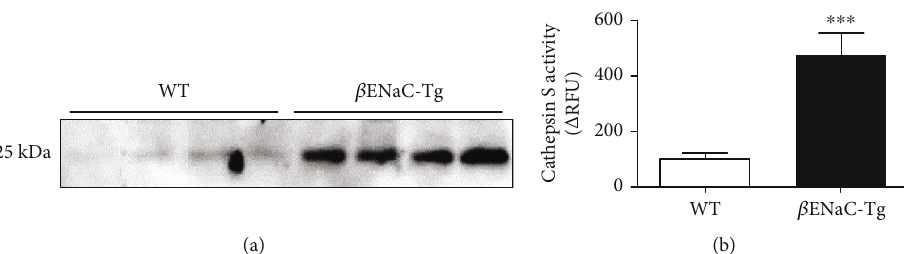
Figure 1: Levels and activity of cathepsin S are upregulated in the lungs of adult β ENaC-Tg mice. (a) Western blot of cathepsin S in BAL fl uid from adult (6 weeks old) β ENaC-Tg and WT mice ( n = 4 per group). Cathepsin S activity in (b) BAL fl uid from adult WT and β ENaC-Tg mice ( n = 8 per group) was determined using FR-AMC substrate (pH 7.5). Results expressed as change ( Δ ) in relative fl uorescence units ( Δ RFU) over time. ∗∗∗ P < 0 : 001 (unpaired two-tailed t